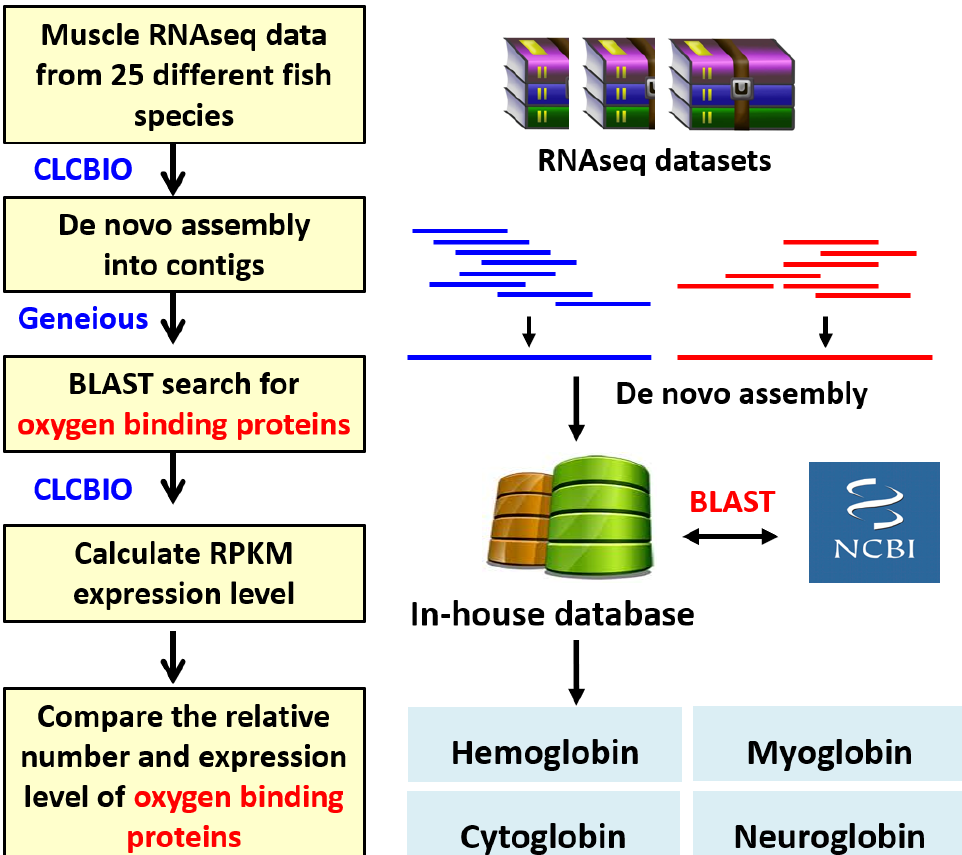
Figure 1. Summary of the experimental workflow from bioinformatic analysis of the expression of oxygen-binding proteins in fish. We performed de novo gene assembly, gene mining by BLAST search, and gene mapping to compare the expressional level of four major oxygen-binding proteins (hemoglobin, myoglobin, cytoglobin, and neuroglobin) in 25 different fish species.